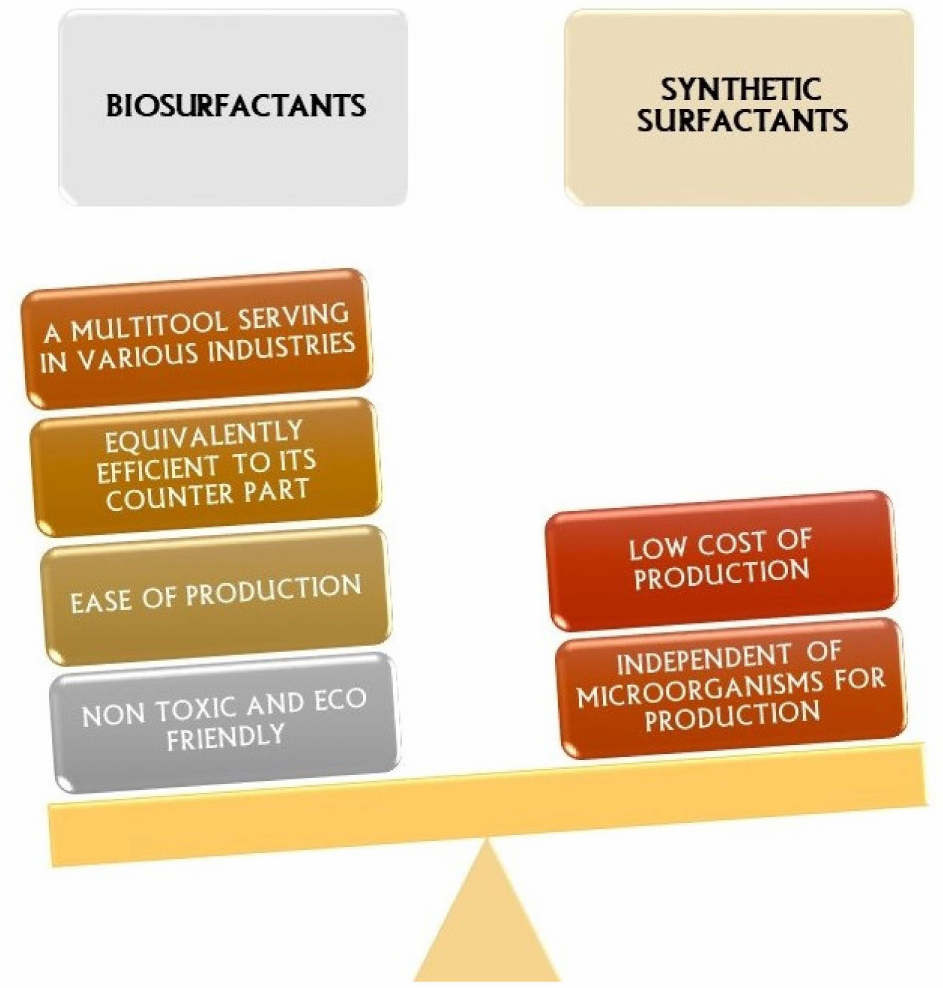
Figure 10. Comparison between biosurfactant and synthetic